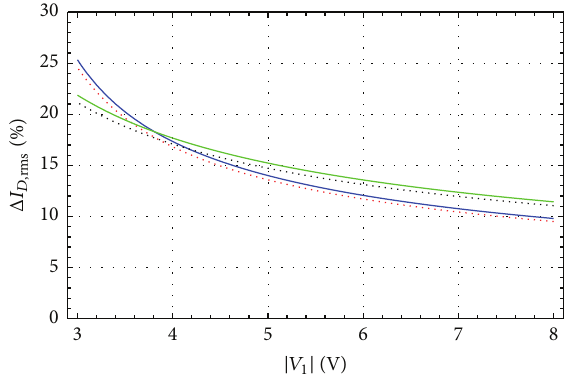
Figure 5: Triode and saturation regions P-type FGMOSFET based comparative plots of Δ𝐼 𝐷, rms ,𝑀 and Δ𝐼 𝐷, rms , SPICE against |𝑉 1 | where | = 0. |𝑉 2